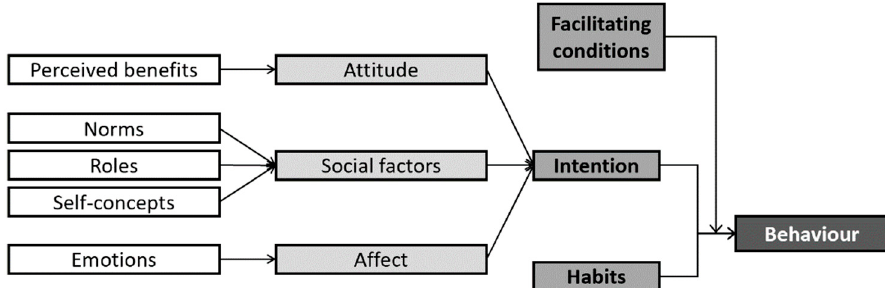
Figure 3. Triandis’s theory of interpersonal behaviour modified for interviews.